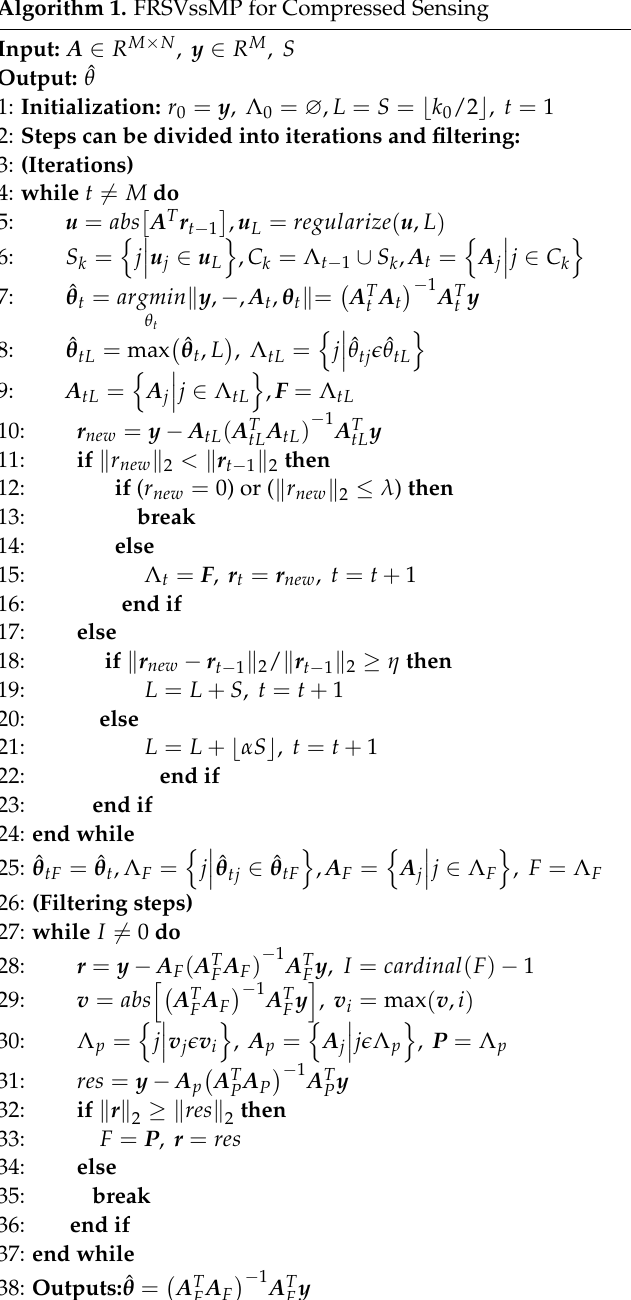
Algorithm 1. FRSVssMP for Compressed